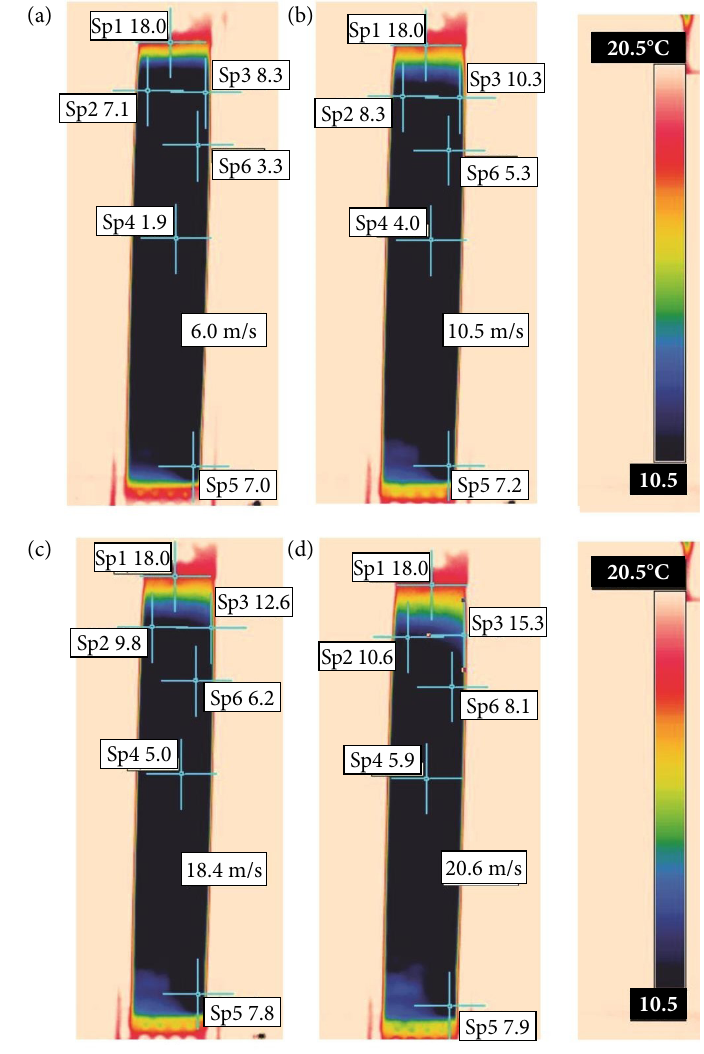
Figure 14. Infrared images in airspeeds below flutter